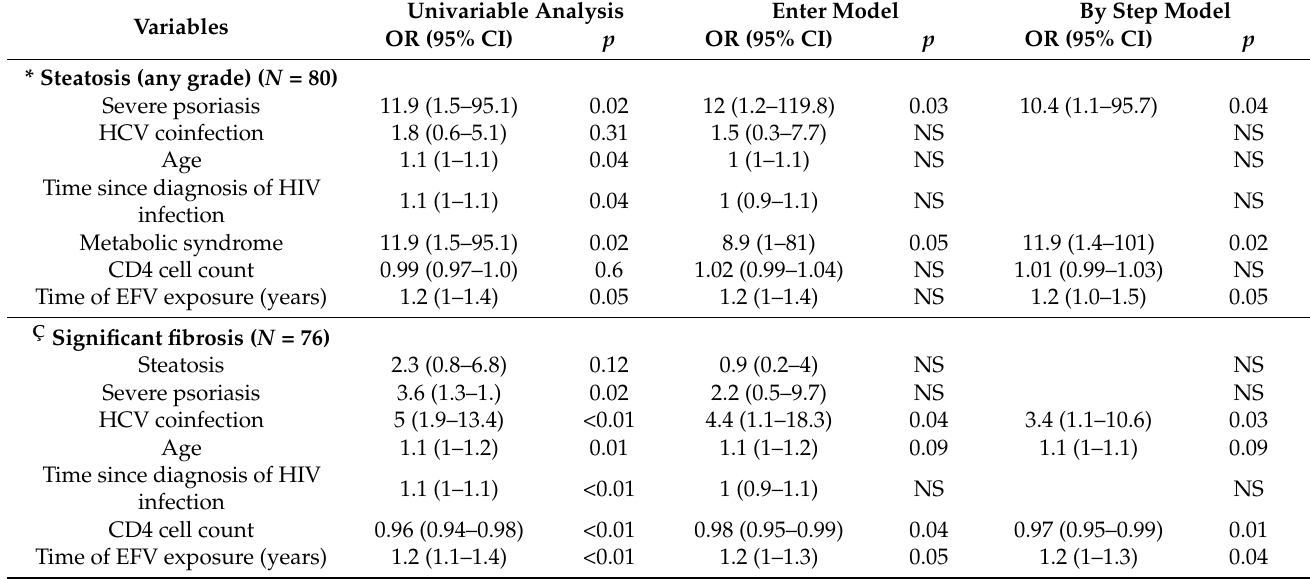
Table 2. Multivariable logistic